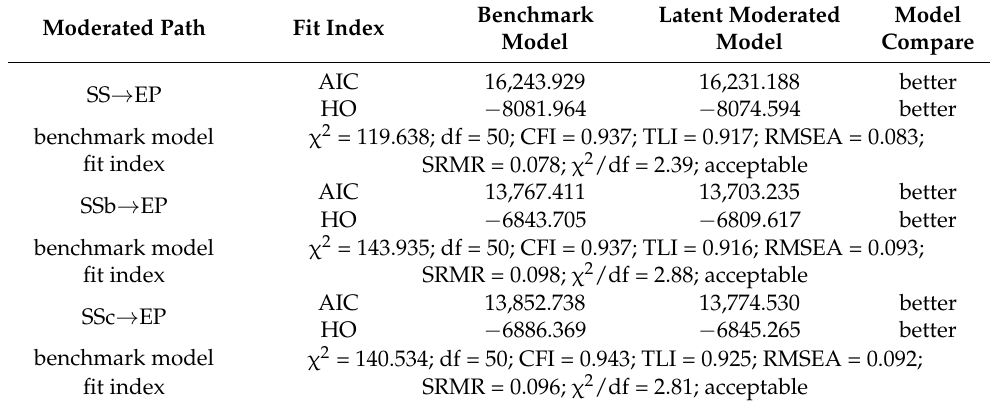
Table 5. Comparison between the benchmark model and latent moderated